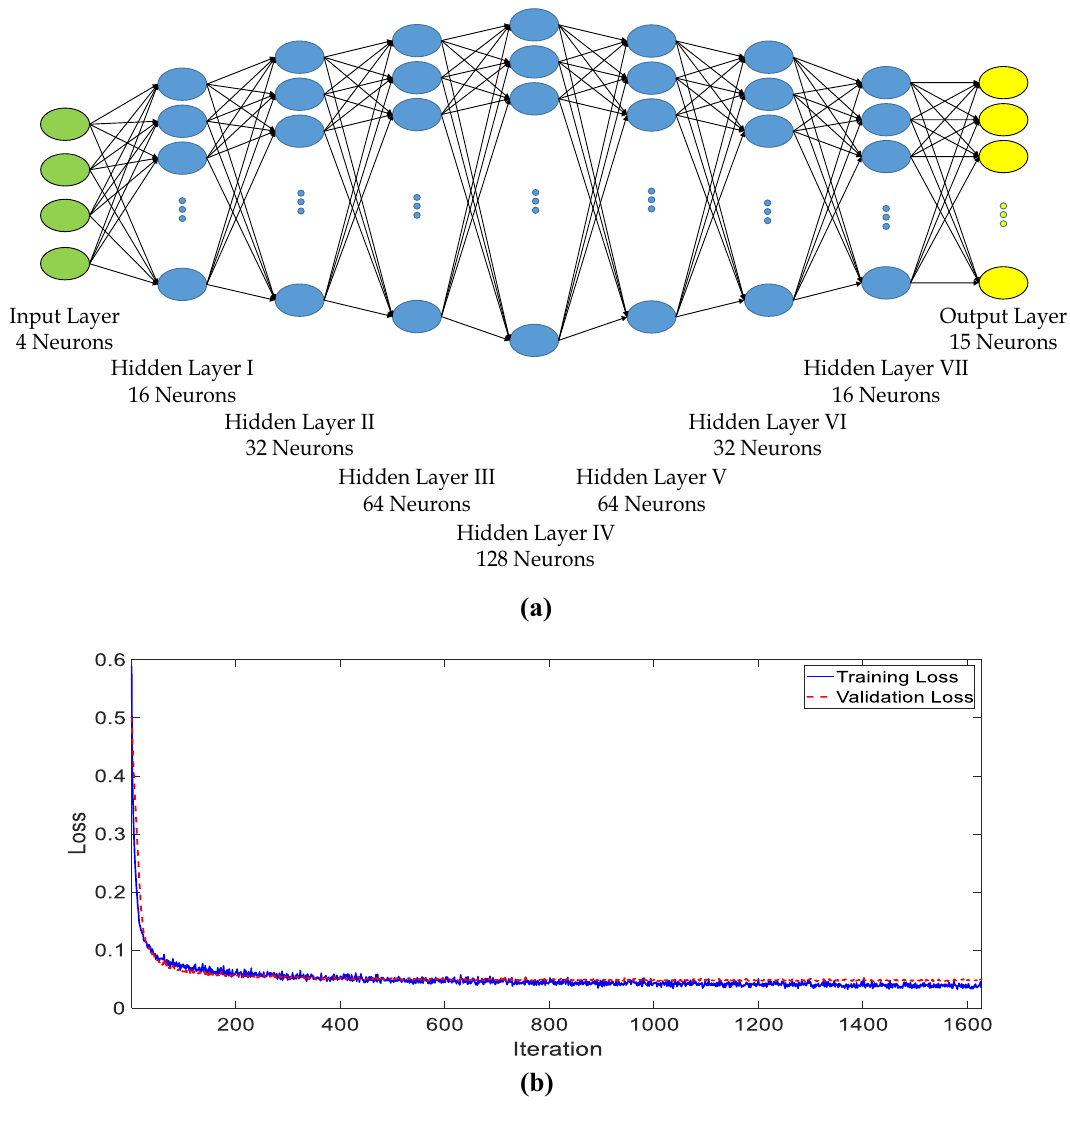
Figure 2. ( a ) The topology of the designed deep neural network including 7 hidden layers with decoder- encoder shape. ( b ) Training loss and validation loss through the training